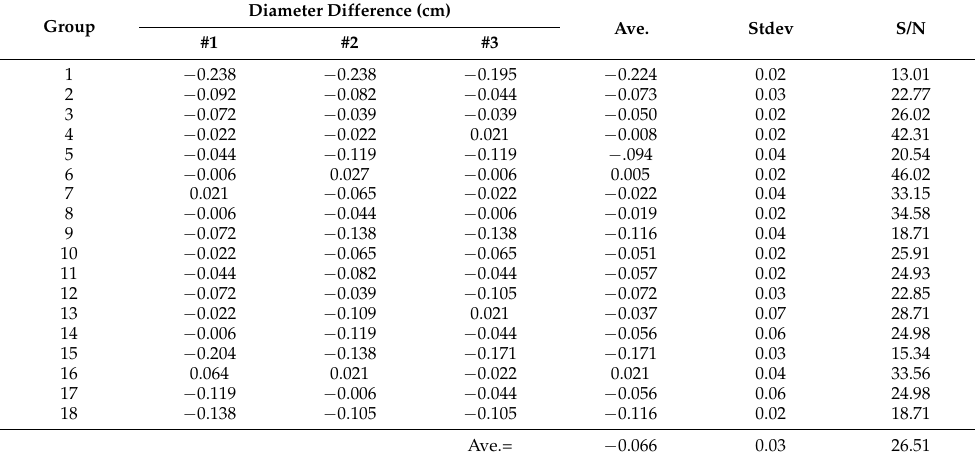
Table 6. The evaluation results obtained from three independent measurements via Equation (6). The diameter difference is defined as the difference between the practical survey and the theoretical survey (0.8